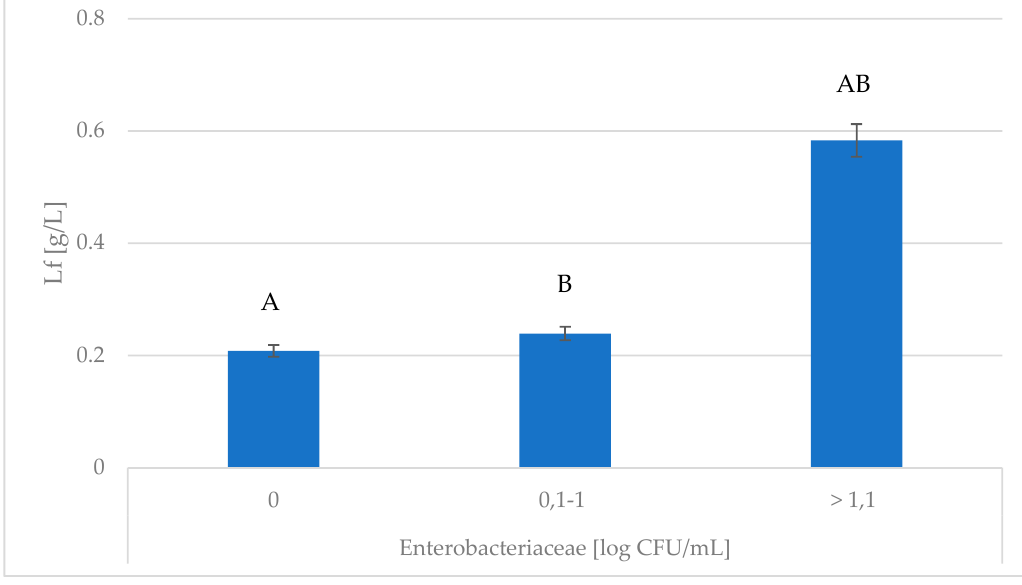
Figure 2. Association of Enterobacteriaceae with changes in Lf content. Lf—lactoferrin; A,B Means with the same letters differ significantly at: capitals— p ≤ 0.01;